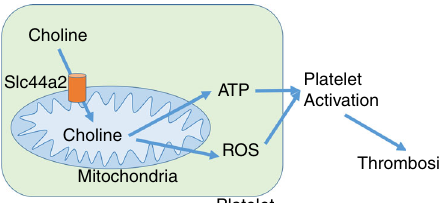
Fig. 5 Proposed model for choline transport and Slc44a2 regulation of platelet activation. We propose that Slc44a2 transports choline into mitochondria, where it is metabolized and regulates the production of ATP and release of ROS. ATP is released from platelets and hydrolyzed to ADP which acts upon platelet purinergic receptors and drives further platelet